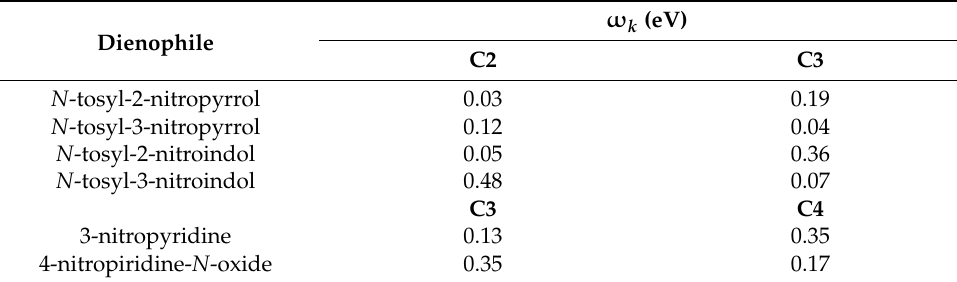
Table 4. Local electrophilicity indices for